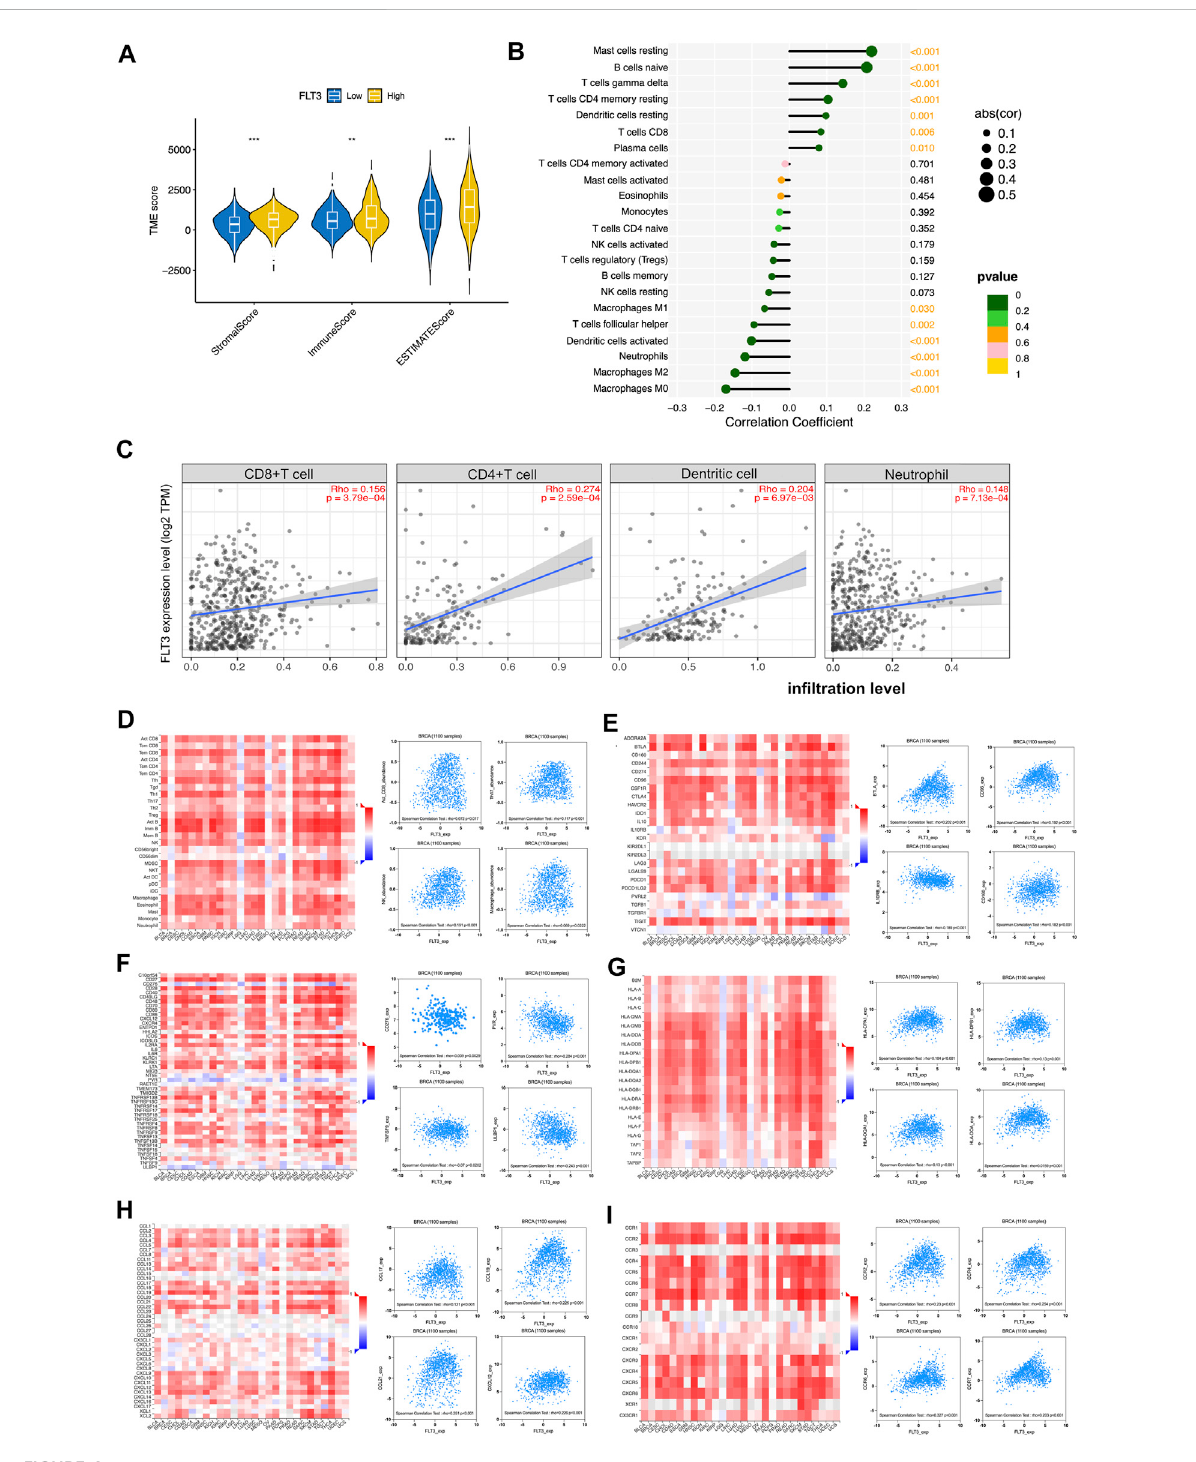
FIGURE 4 Associations of the FLT3 expression level with tumor immune in fi ltration in BC. (A) The correlation between FLT3 expression and TME scores, which was subdivided into stromal scores, immune scores, and ESTIMATE scores. (B) The correlation between the abundance of 28 immune cells and FLT3 expression. (C) The correlation of FLT3 expression with in fi ltration levels of CD4+T cell, CD8 + cell, dendritic cell, and neutrophil in BC is available on the TIMER 2.0 database. (D) Correlations between the abundance of tumor-in fi ltrating lymphocytes (TILs) and FLT3 (plus the four anti-tumor immune cells which have positive correlation with FLT3) in the TISIDB database. (E – G) Correlations between immunomodulators and FLT3(plusthefourimmunomodulatorswiththehighestcorrelation, respectively) intheTISIDBdatabase. (H,I) Correlationsbetweenchemokines(or receptors) and FLT3 (plus the four chemokines (or receptors) which highly correlates with anti-tumor immune cells, respectively) in the TISIDB database. The asterisks represent the statistical p -value (ns: p > 0.05, * p ≤ 0.05, ** p ≤ 0.01, *** p ≤ 0.001, **** p ≤